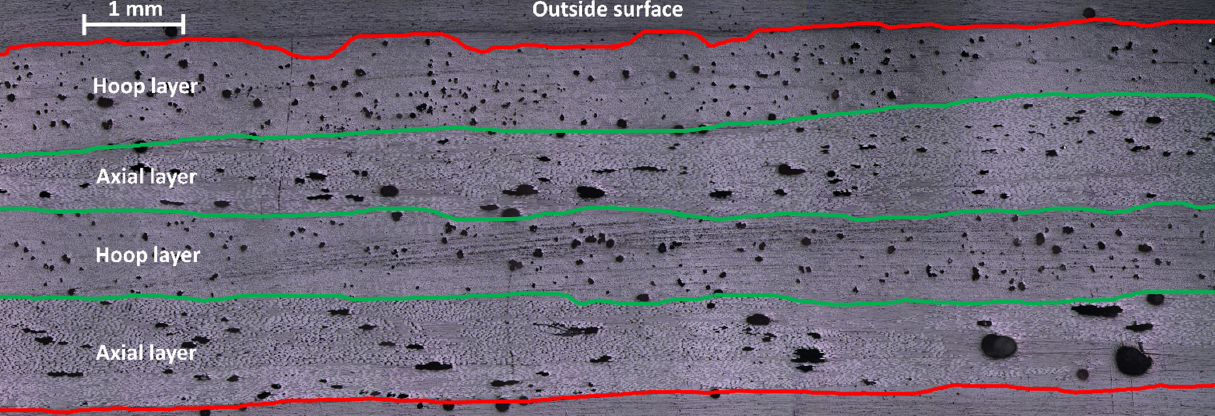
Figure 19. Microscopy of the split disk specimen. As can be seen there are many voids (black) and a big variation in layer thickness over the cross section.